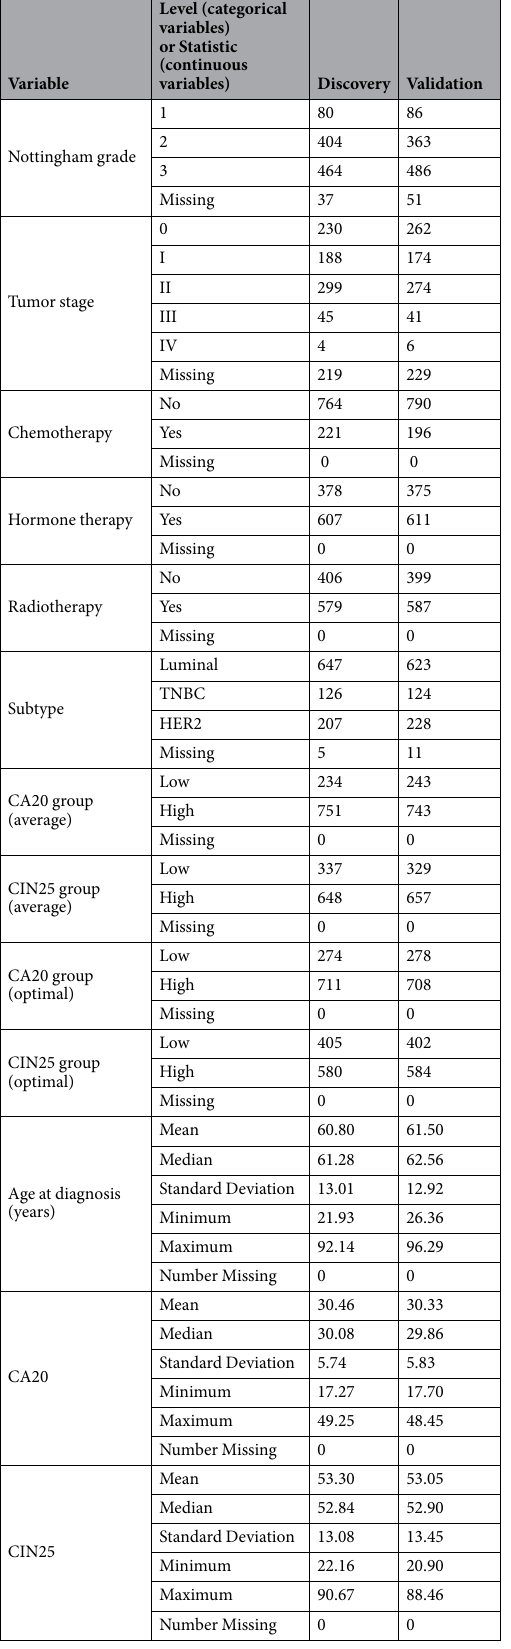
Table 1. Descriptive statistics for the METABRIC breast discovery and validation